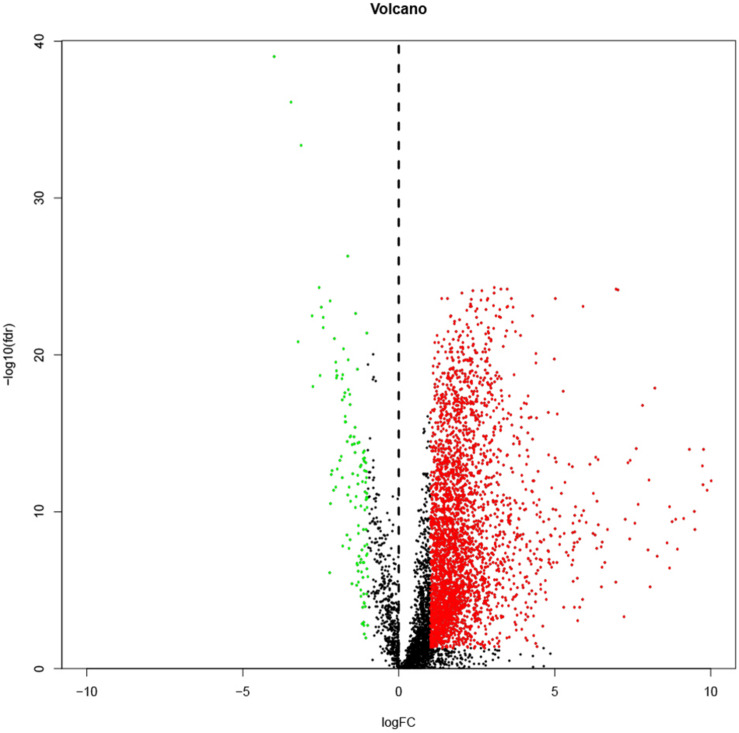
A volcano map showing all lncRNAs. Black dots represent insignificant lncRNAs in tumor tissues; green and red dots represent down-regulated and up-regulated lncRNAs in tumor tissues.